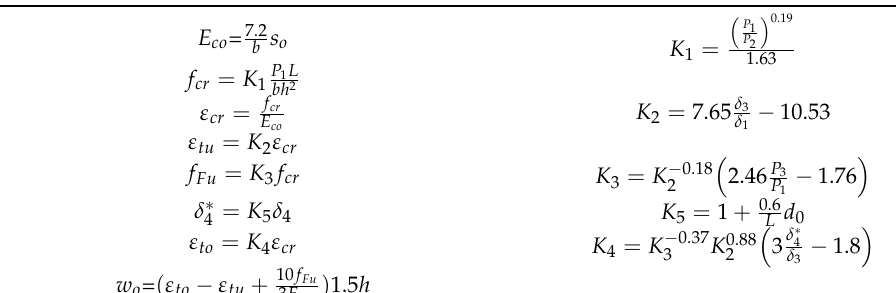
Table A1. Inverse analysis parameters.